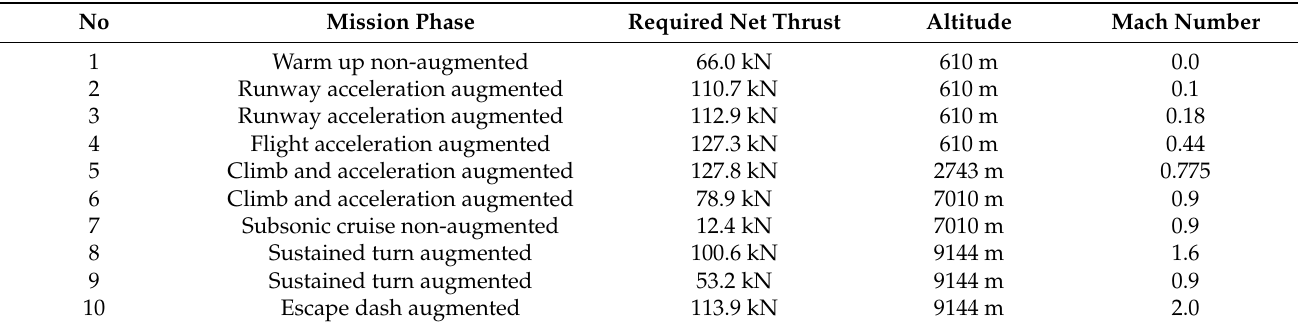
Table 2. Key parts of mission [41]. For the mission phase specification, “augmented” refers to use of